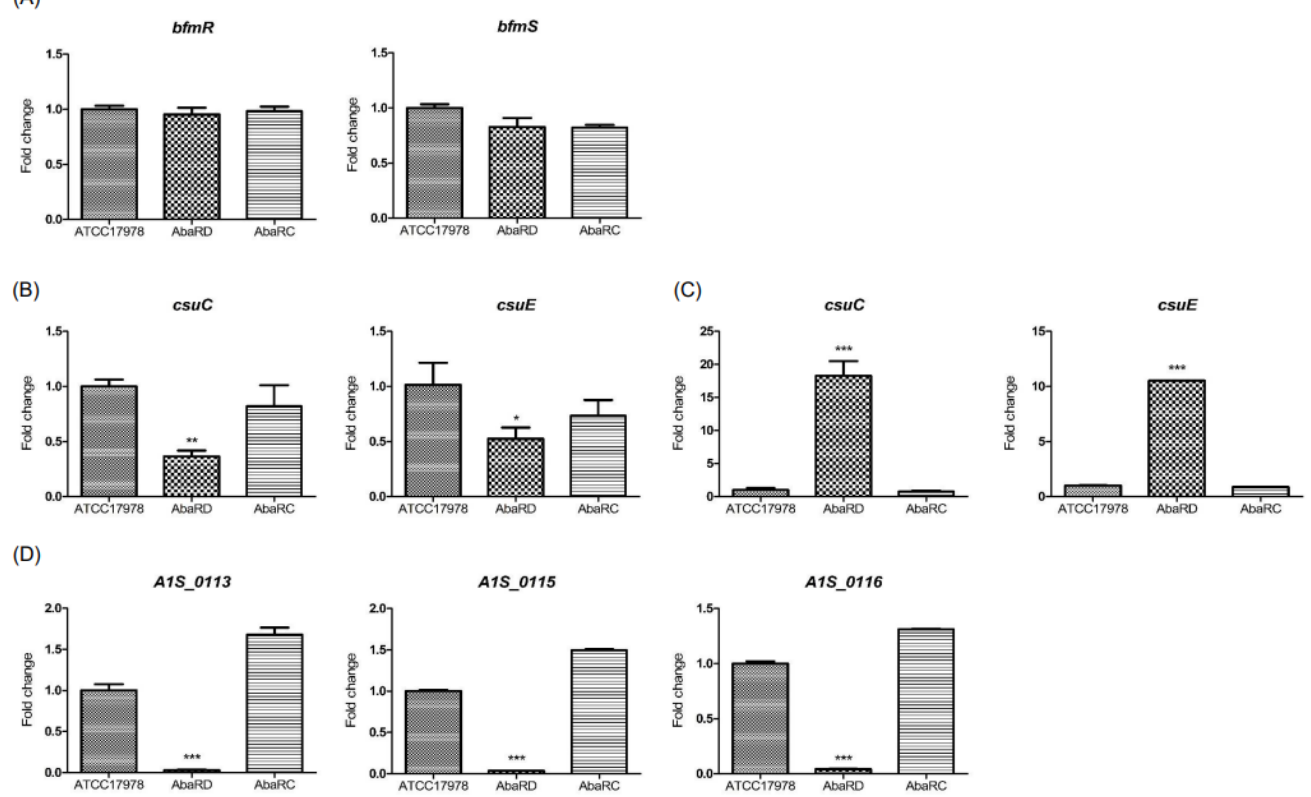
Figure 5. Gene expression in the Δ abaR mutant strain. A. baumannii ATCC 17,978 (wild-type), AbaRD ( Δ abaR mutant), and AbaRC ( abaR -complemented strain) were grown in LB without salt to an OD 600 of 1.0 or 2.0 under static conditions. qPCR was performed to analyze the expression of genes. ( A ) The expression of bfmR and bfmS in the Δ abaR mutant strain cultured to an OD 600 of 2.0. ( B ) The expression of csuC and csuE in the Δ abaR mutant strain cultured to an OD 600 of 1.0. ( C ) The expression of csuC and csuE in the Δ abaR mutant strain cultured to an OD 600 of 2.0. ( D ) The expression of A1S_0113 , A1S_0115 , and A1S_0116 in the Δ abaR mutant strain cultured to an OD 600 of 2.0. The data are presented as the mean ± SEM of three independent experiments. * p < 0.05, ** p < 0.01, *** p < 0.001 compared to the WT strain.